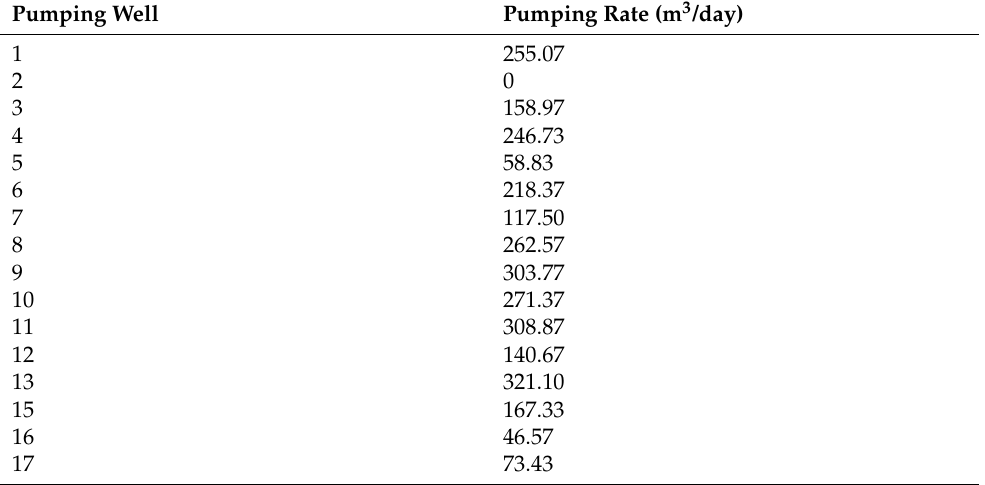
Table 3. Pumping rates on the east side of the Ptujsko polje aquifer for the time used in the model. Pumping